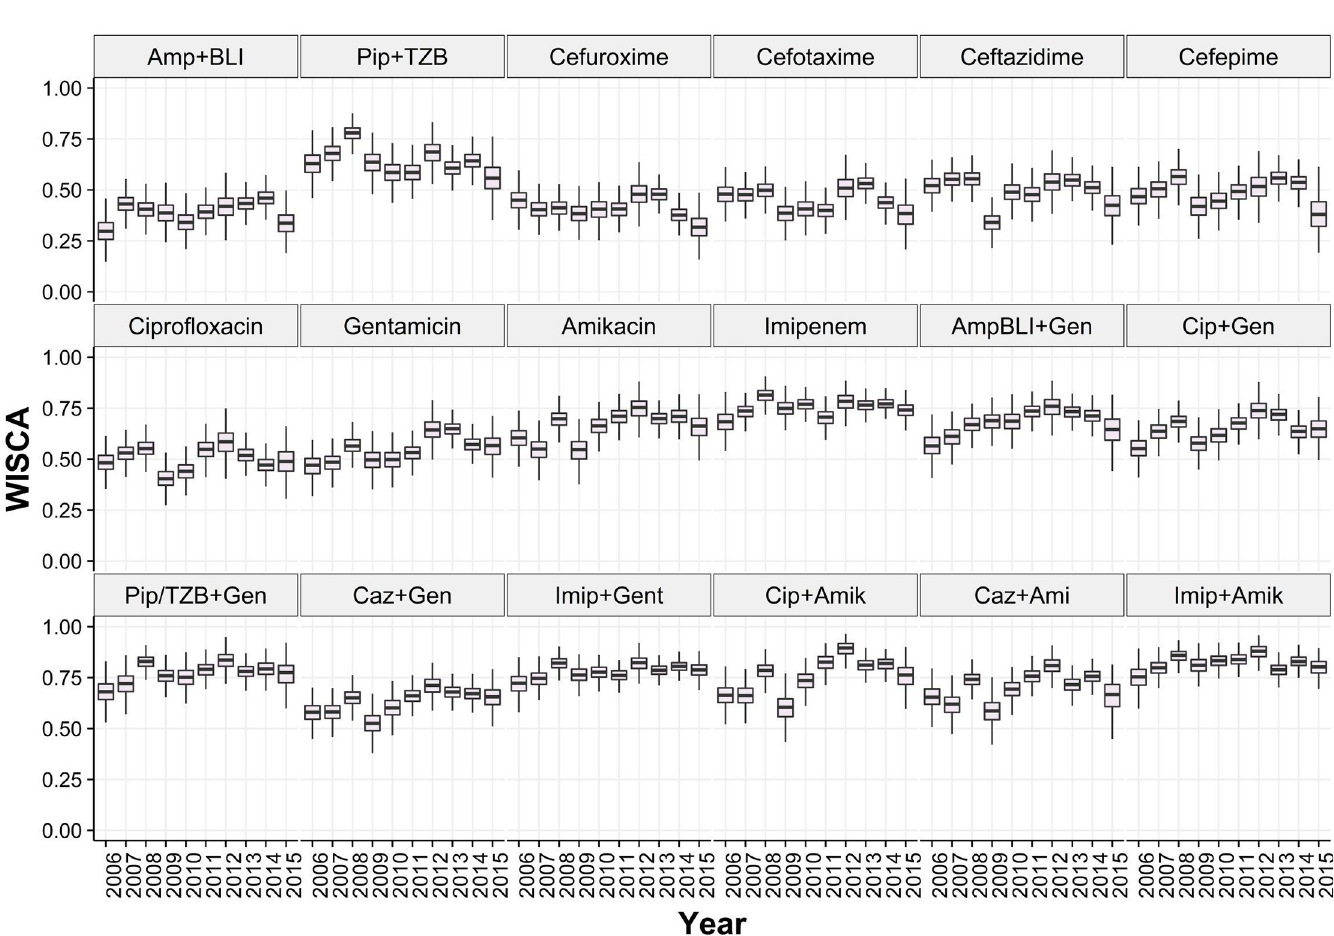
Fig 6. Estimated Bayesian WISCA (informative prior) of antibiotic choices in HAUTIs reported in European urology departments from 2006 to 2015.